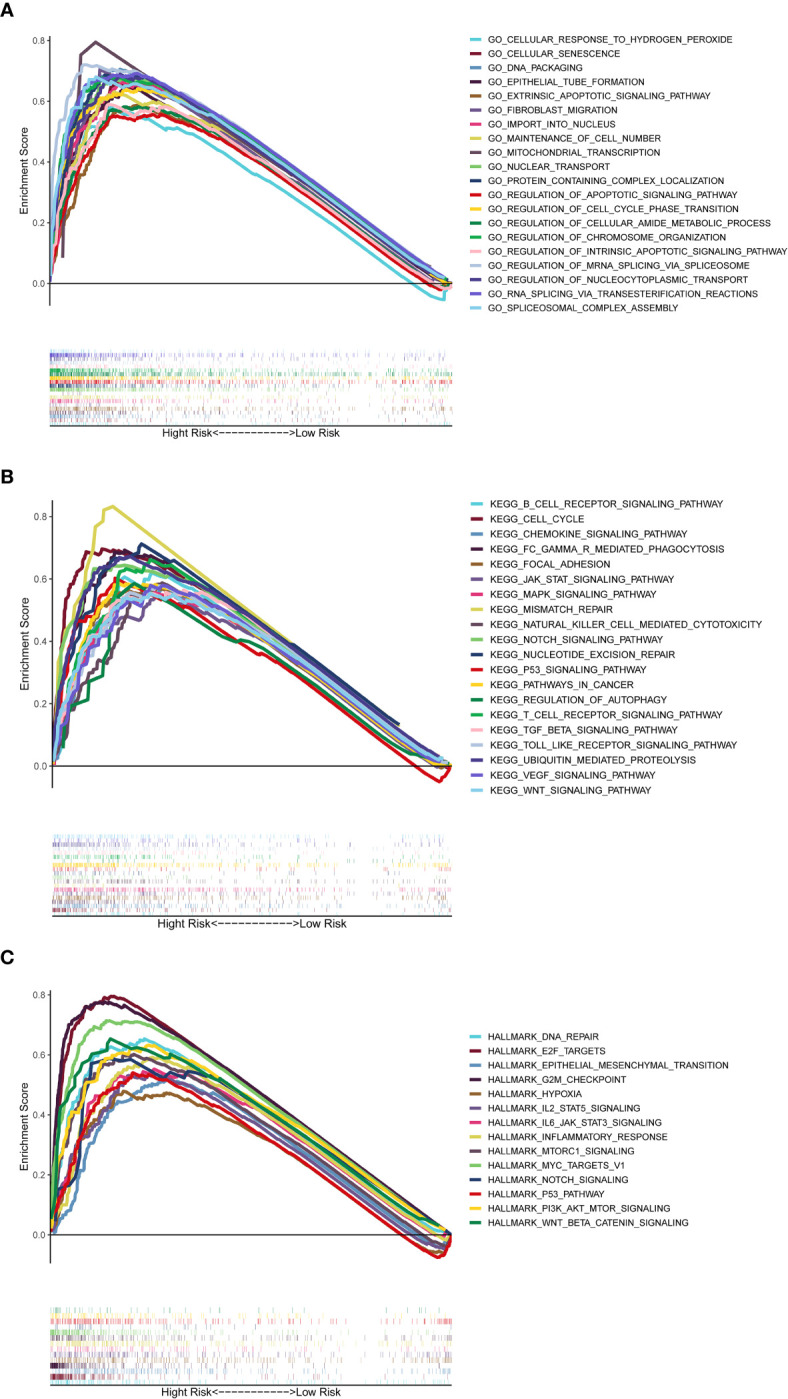
Gene set enrichment analysis of Biological functions and pathways. (A) GO, Gene Ontology. (B) KEGG, Kyoto Encyclopedia of Genes and Genomes. (C) Hallmark gene set.